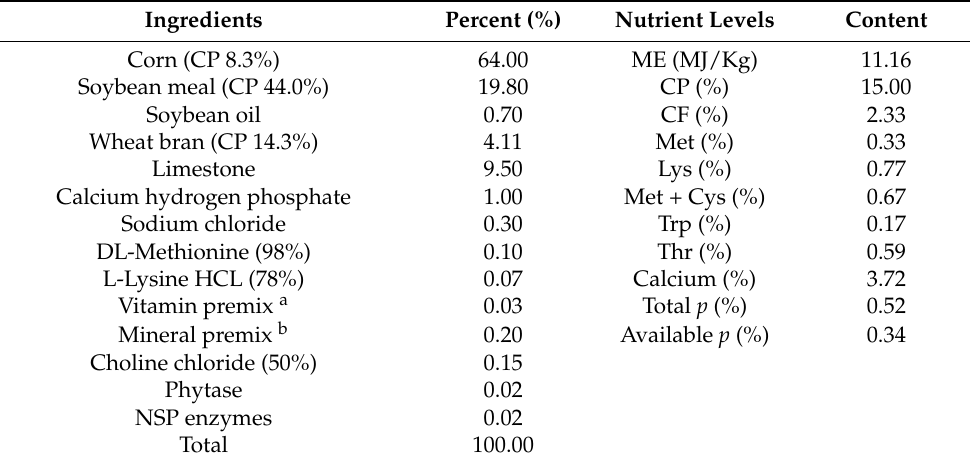
Table 1. The ingredients and nutrient composition of the basal